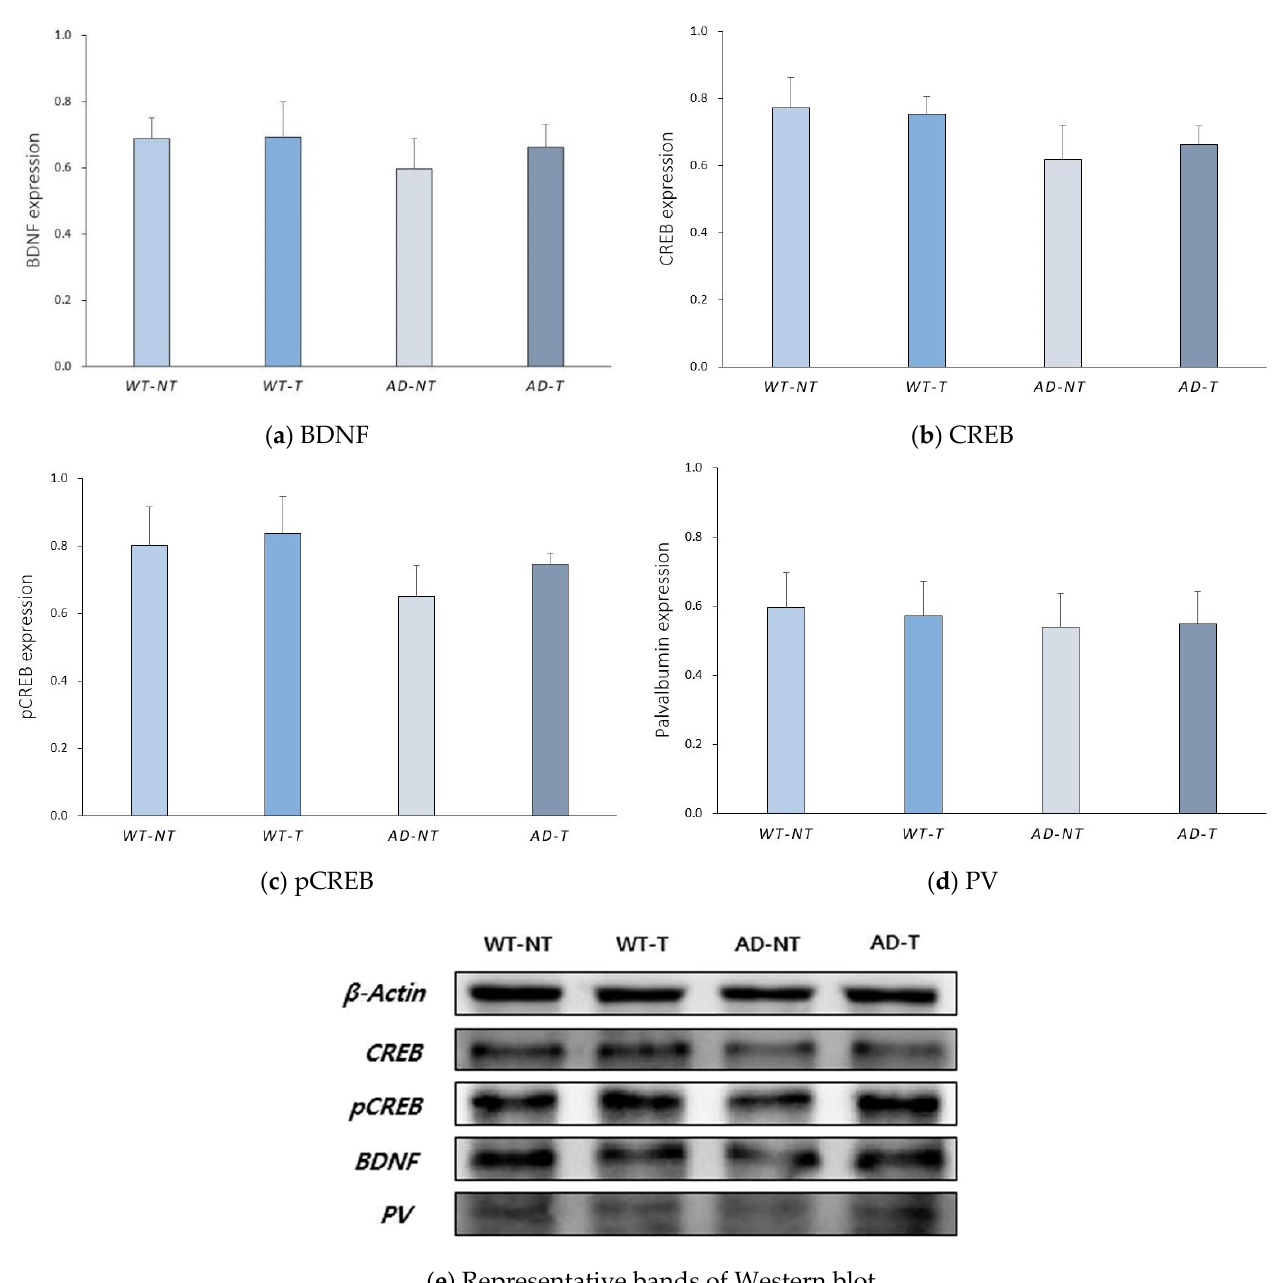
Figure 2. Western blot analysis of brain-derived neurotrophic factor (BDNF), cyclic AMP response element-binding protein (CREB), phosphorylated CREB (pCREB), and parvalbumin (PV). ( a ) Quantitative BDNF expression level in the WT-NT group (0.69 ± 0.06), the WT-T group (0.69 ± 0.11), the AD-NT group (0.60 ± 0.09), and the AD-T group (0.66 ± 0.07). ( b ) Quantitative CREB expression level of the WT-NT group (0.77 ± 0.09), the WT-T group (0.75 ± 0.05), the AD-NT group (0.62 ± 0.10), and the AD-T group (0.66 ± 0.06). ( c ) Quantitative pCREB expression level of the WT-NT group (0.80 ± 0.11), the WT-T group (0.84 ± 0.11), the AD-NT group (0.65 ± 0.09), and the AD-T group (0.75 ± 0.03). ( d ) Quantitative PV expression level of the WT-NT group (0.60 ± 0.10), the WT-T group (0.57 ± 0.10), the AD-NT group (0.54 ± 0.10), and the AD-T group (0.55 ± 0.09). ( e ) Representative bands of CREB, pCREB, BDNF, and PV. The data from each group show the mean values and standard errors (SE). A statistical analysis was performed using the Kruskal–Wallis test and the Bonferroni method for post hoc analysis.